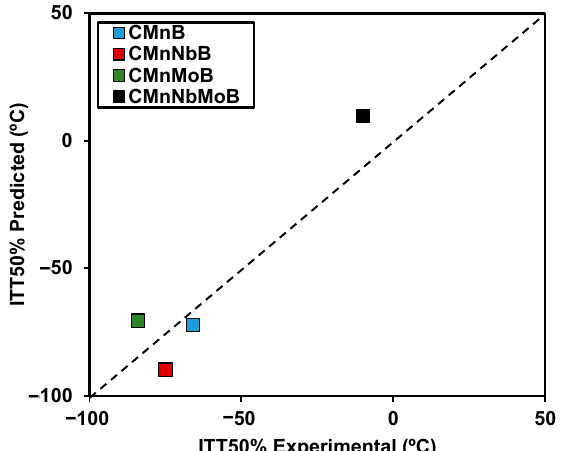
Figure 11. Correlation between predicted ITT50% considering Equation (3) and the experimental ITT50% measured by Charpy tests.